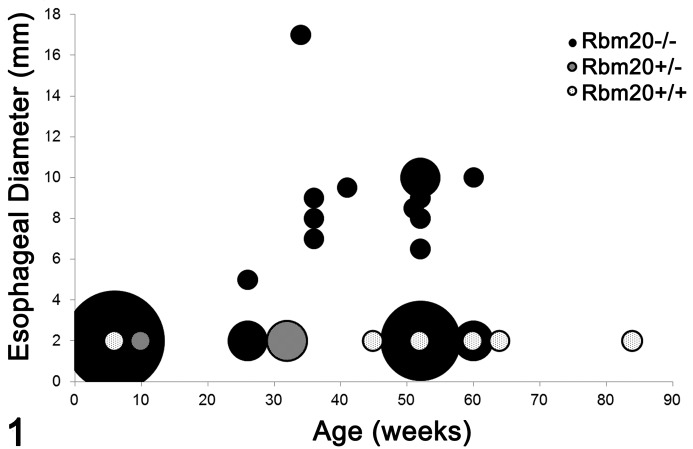
Bubble plot of closed esophageal diameter (mm) vs age (weeks) in rats of all Rbm20 genotypes. The width of the bubble represents the number
of rats with this age and esophageal diameter. Most animals of all genotypes and ages
had esophageal diameters of 2 mm. Diameters larger than 5 mm were considered dilated;
all rats with megaesophagus were Rbm20–/–. Note
that 1 heterozygote with megaesophagus did not have a measurement for the diameter; this
animal is excluded from this plot.